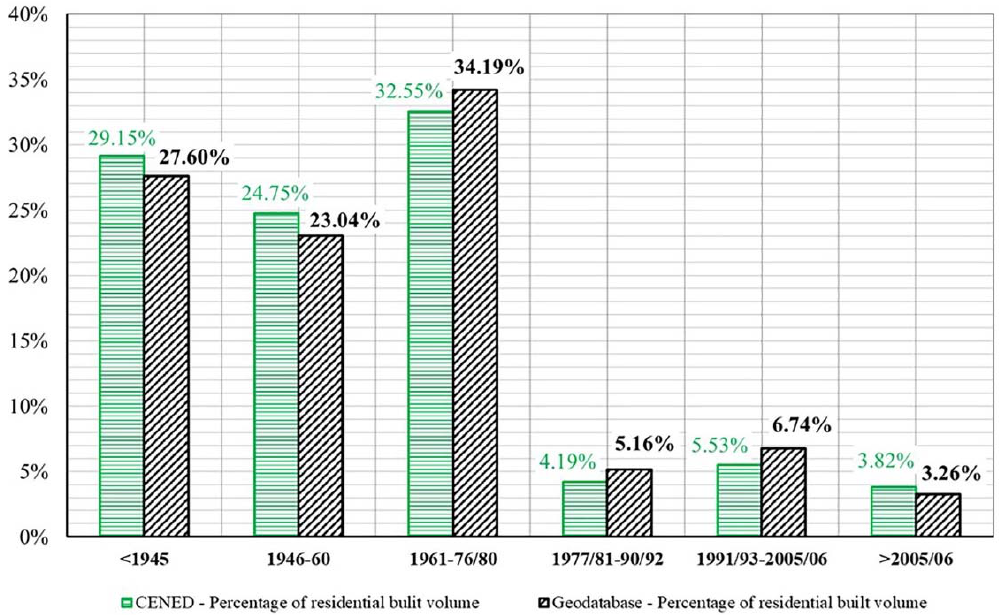
Figure 10. Comparison of distribution of residential built volume by period of construction according to the CENED municipal data and the Geo-database elaborations.